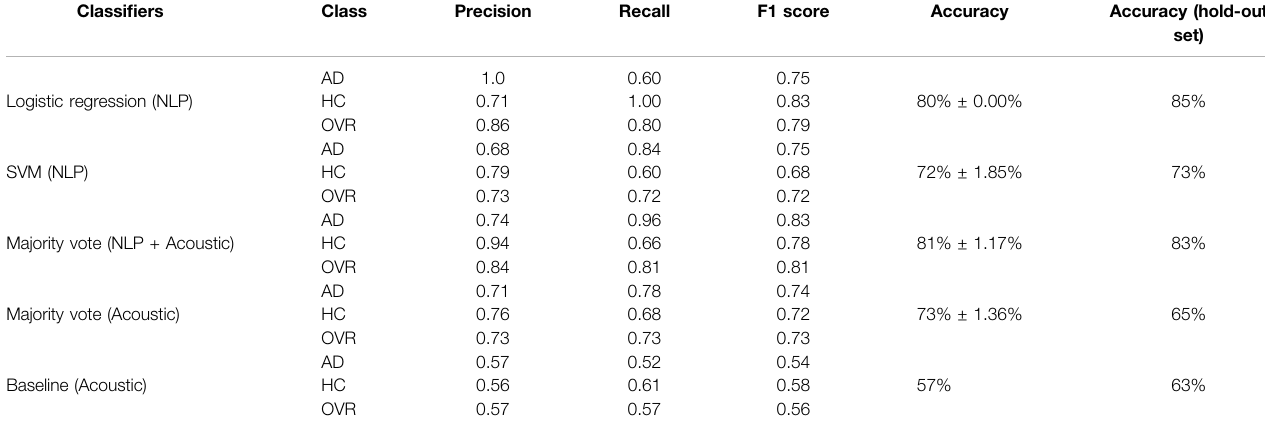
TABLE1| Resultsofourbestperformingclassi fi cationmodelsdistinguishingADfromnon-ADsubjects.The “ Baseline(Acoustic) ” modelisdescribedinLuzetal.(2020).The right-most column shows accuracy on the held-out test set of 48 subjects (24 AD and 24 non-AD). The rest of the table lists model performance using 5-fold cross- validation on the training set of 108 subjects (54 AD and 54 non-AD). Classi fi